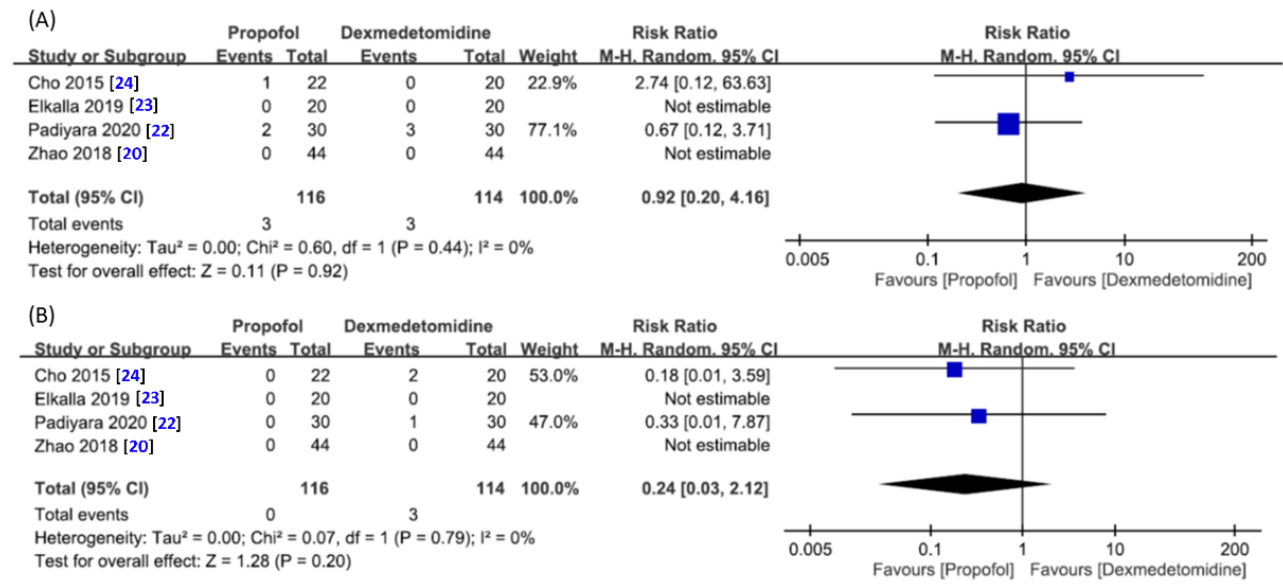
Figure 7. Forest plot for the comparison of ( A ) risk of hypotension or ( B ) risk of bradycardia during drug-induced sedation endoscopy between propofol and dexmedetomidine groups. CI, confidence interval; M–H, Mantel–Haenszel.